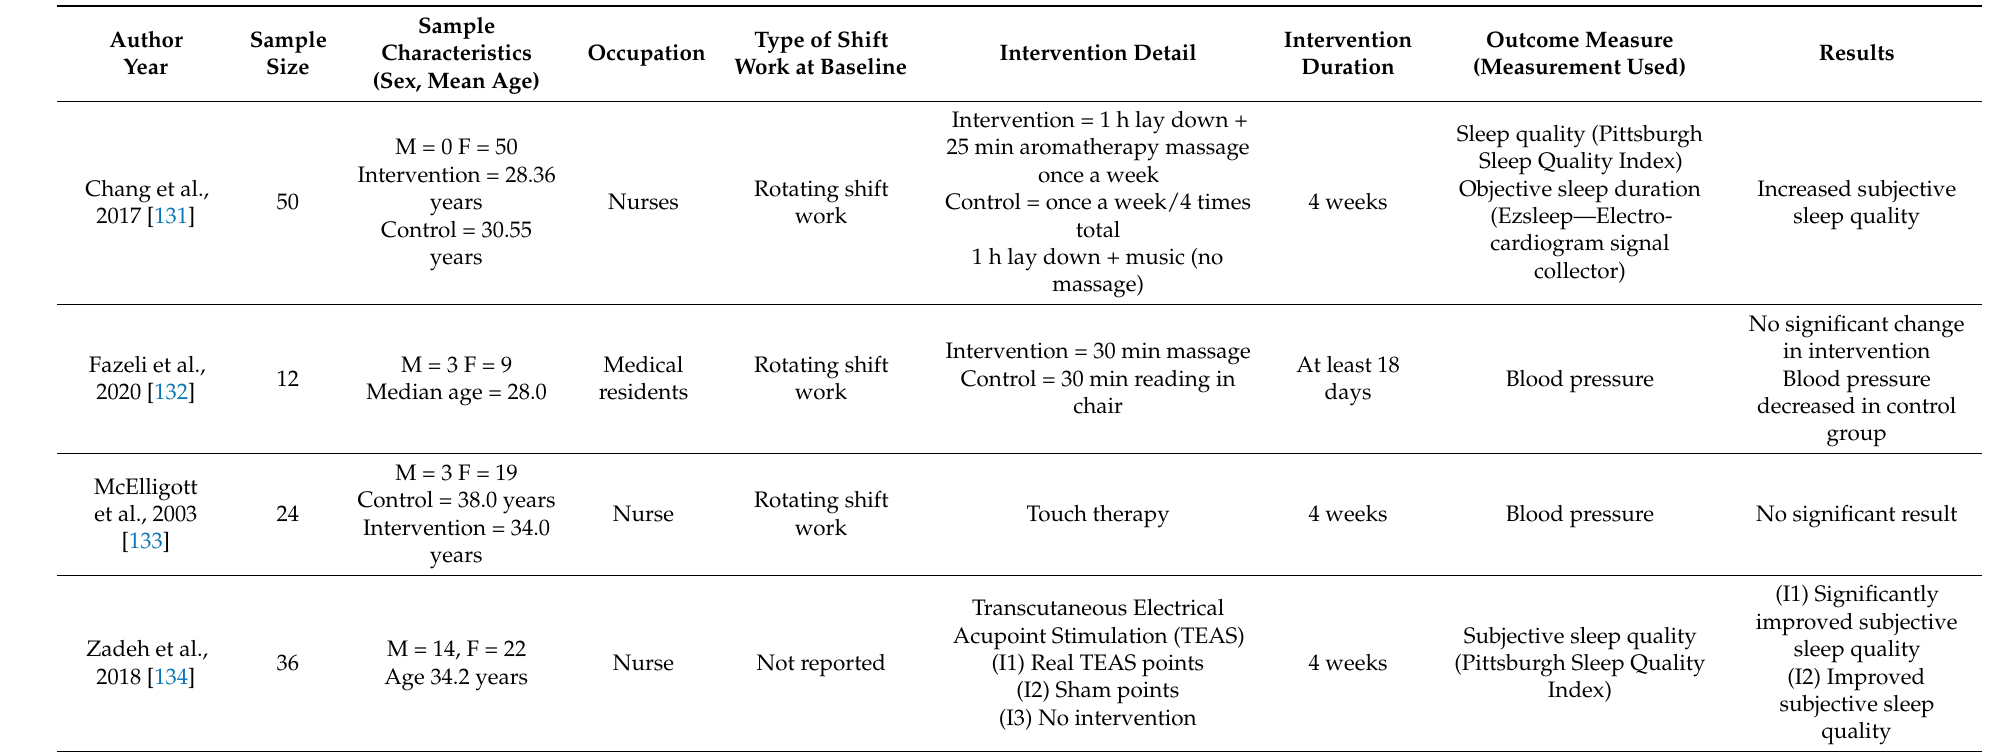
Table 6. Studies investigating complementary